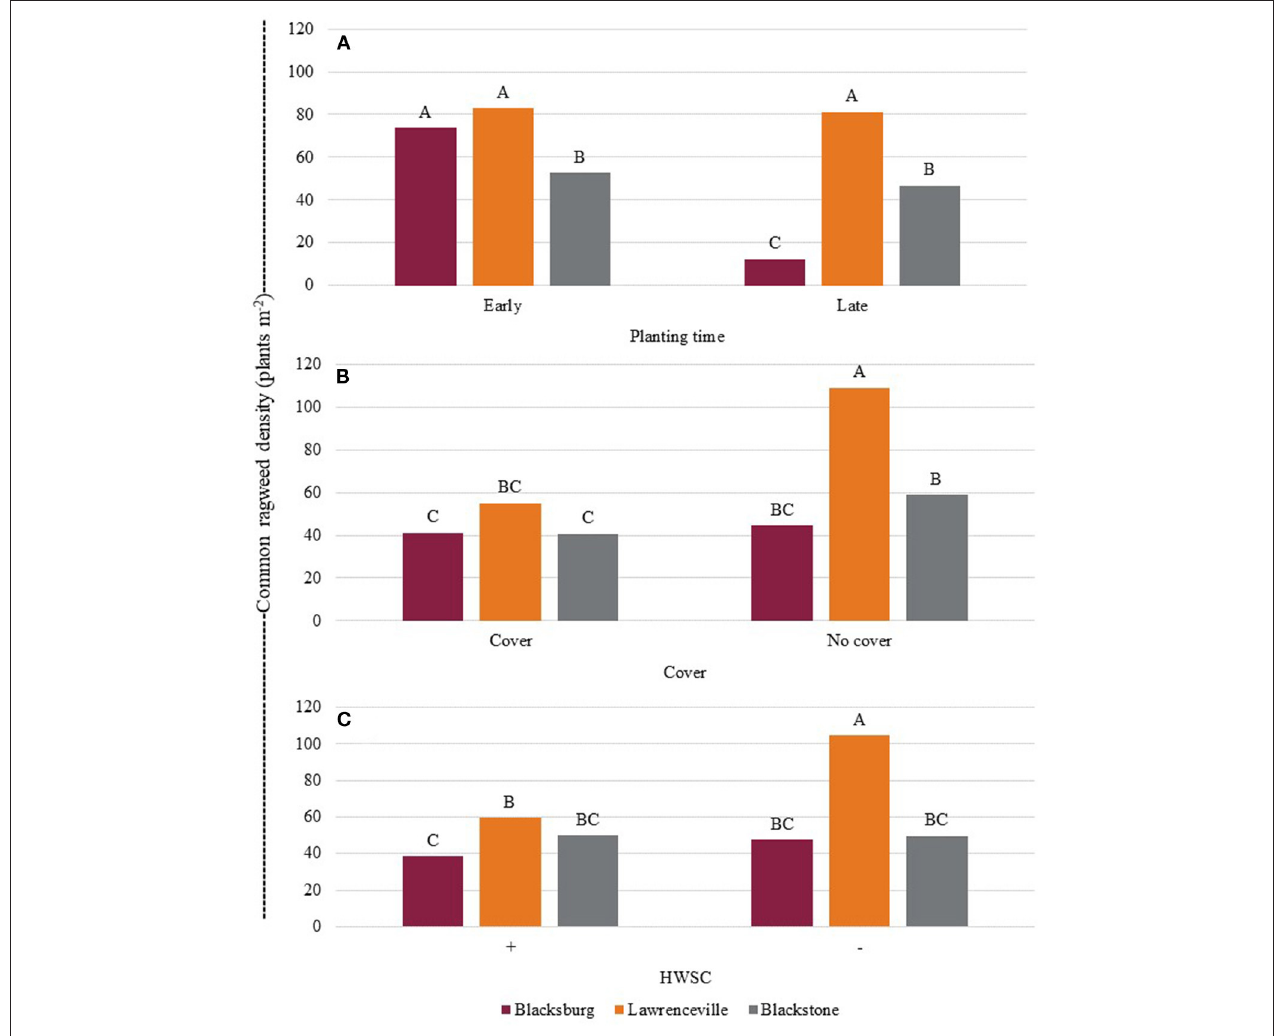
FIGURE 4 | Common ragweed density at preplant herbicide application in year 2 of the experiment (A) by location and planting time (B) by location and ± winter cover and (C) by location and ± harvest weed seed control (HWSC) prior to preplant herbicide application. Means are considered statistically different when they do not share a letter according to Fisher’s Protected LSD ( P = 0.05)